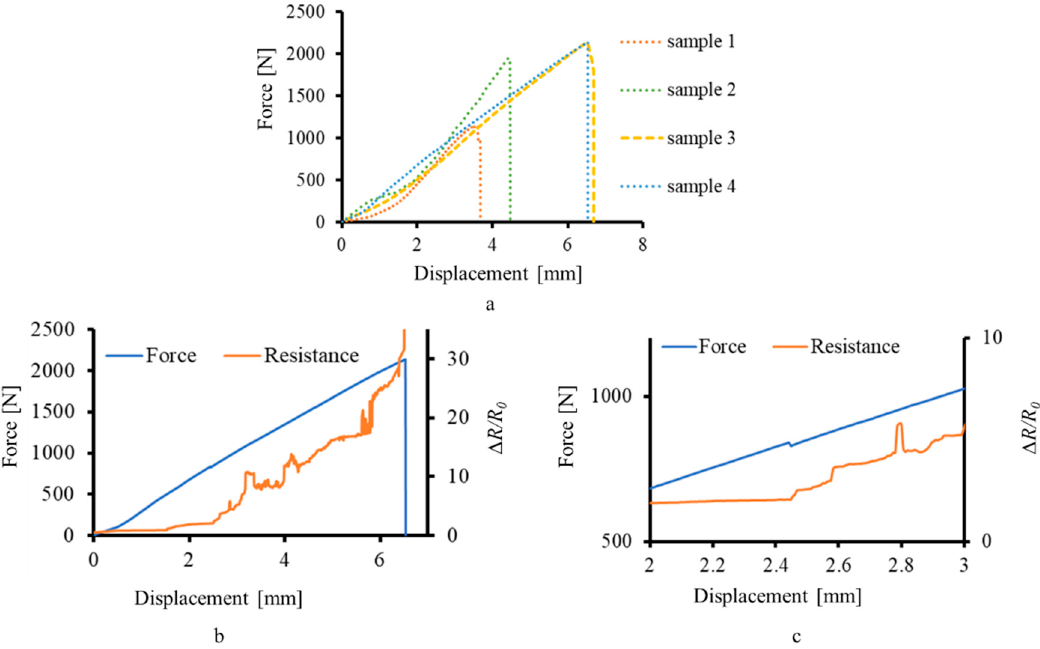
Figure 4. Real-time deformation monitoring of composite T-profile: ( a ) tensile testing of composite T-profile; ( b ) piezoresistive response of the MXene coating; ( c ) enlarged section of initial failure. Table 2. Correlation coefficient and ultimate tensile